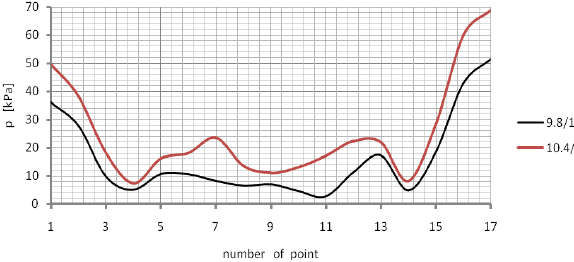
Figure 15: Diagrams of the pressures acting on the shell in the initial phase of construction of the overburden